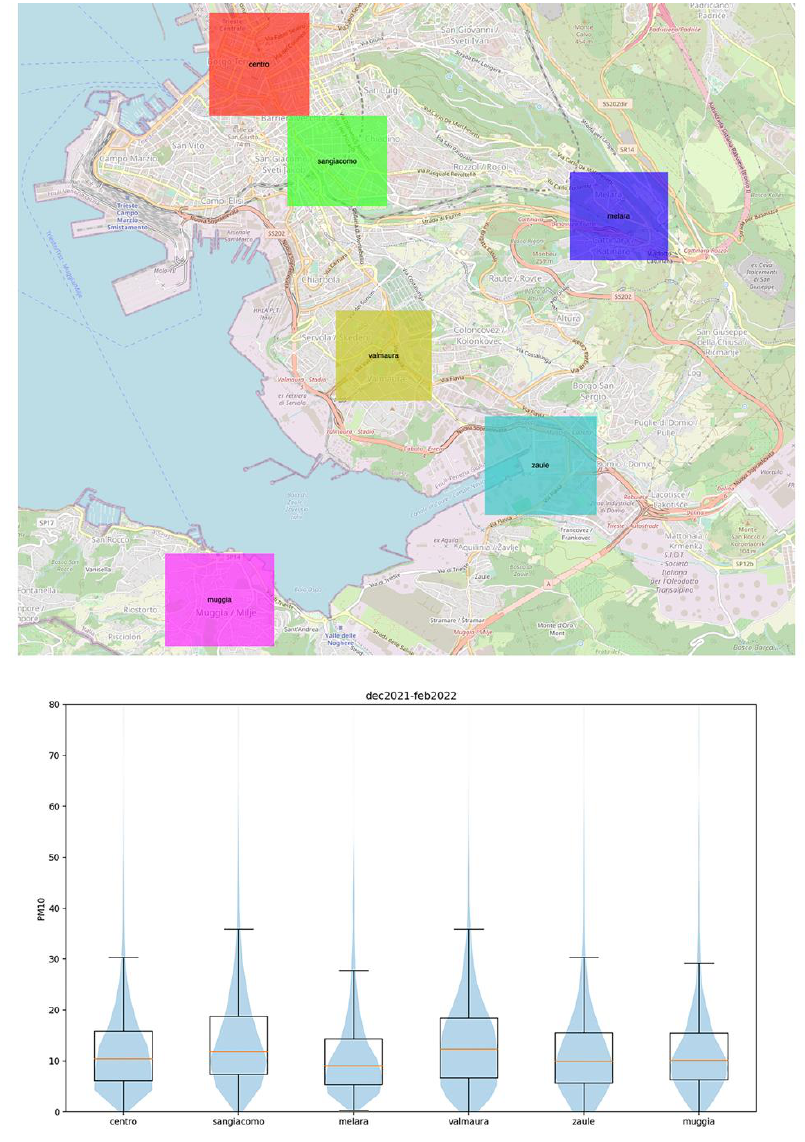
Figure 9. The six areas selected for the air quality comparison (upper); violin plots of PM concentrations in the different areas (lower).